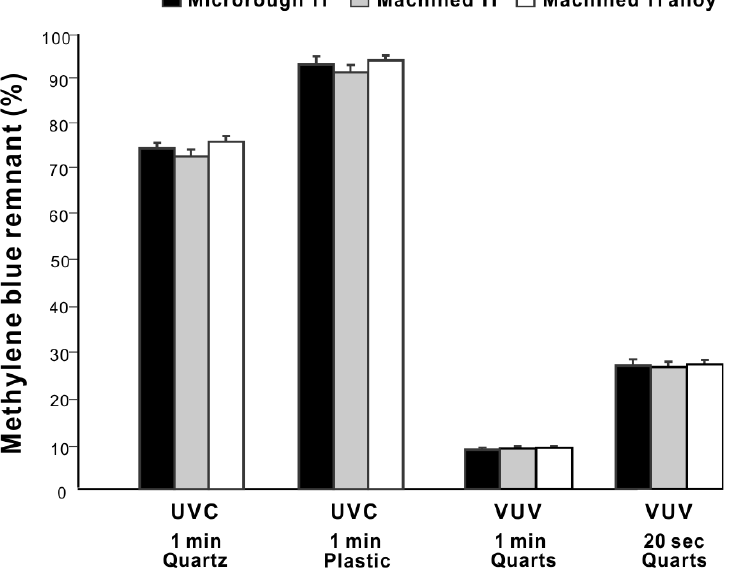
Figure 7. Effects of different titanium materials and surfaces on UV-mediated organic decomposition. UV treatment was conducted under the selected conditions with either microroughened commercially pure titanium, machined commercially pure titanium, or machined grade 5 titanium alloy. A histogram showing remnant methylene blue after UV treatment (%).